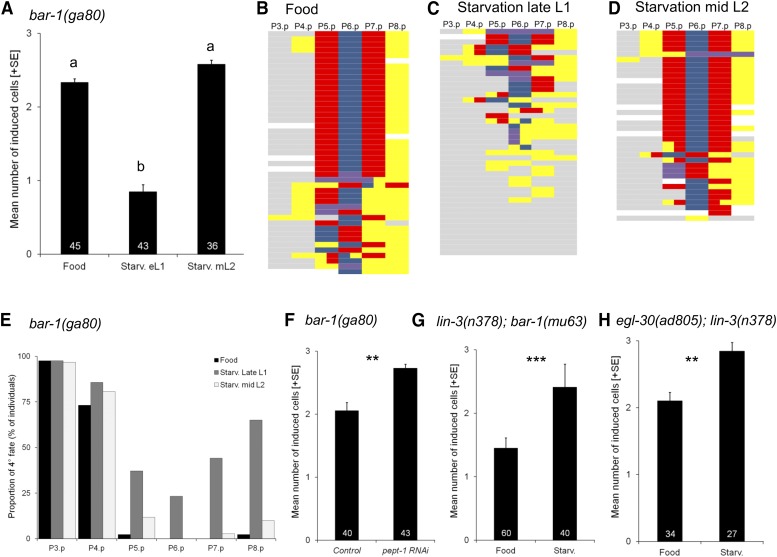
Role of BAR-1 activity in starvation modulation of vulval induction. (A) Differences in vulval induction of bar-1(ga80) animals exposed to 48 hr of starvation in late L1 vs. mid L2 (and vs. control food conditions). Starvation at the late L1 stage, but not at the mid L2 stage, significantly reduced vulval induction of bar-1(ga80) animals (ANOVA, F2,121 = 50.27, P < 0.0001). (B-D) Individual bar-1(ga80) fate patterns of P3.p to P8.p in (B) food vs. starvation conditions: late L1 (C) or mid L2 starvation (D). Vulval cell fate patterns of P3.p to P8.p (B-D) were, whenever feasible, separately inferred for Pn.pa and Pn.pp in cases of half-induced fates. Each line represents the vulval pattern of a single individual, and individuals are ordered from highest to lowest index of vulval induction. Color coding of vulval cell fates (1°: blue, 2°: red) and non-vulval cell fates (3°: yellow, 4°: gray). Induced vulval cells that could not be clearly assigned to either a 1° or 2° fate are coded in purple; non-induced cells that could not be clearly assigned a 3° or° fate are coded in white. (E) Proportion of Pn.p cells with a 4° (Fused) fate in control, starvation-exposed late L1, starvation-exposed mid L2 bar-1(ga80) individuals (from the same experiment as shown in (A)). The proportions of 4° fates for each of P5.p to P7.p cell were higher after L1 starvation (P5.p: 37%, P6.p: 23%, P7.p: 44%) compared to control (P5.p: 2%, P6.p and P7.p: 0%) and L2 starvation (P5.p: 12%, P6.p: 0%, P7.p: 3%). (F) pept-1 RNAi increases vulval induction of bar-1(ga80) animals (ANOVA, F1,81 = 14.47, P = 0.0003). (G) Starvation increased vulval induction of lin-3(n378); bar-1(mu63) relative to control food conditions (ANOVA, F1,98 = 18.84, P < 0.0001). (H) Starvation increased vulval induction of egl-30(ad805); lin-3(n378) relative to control food conditions (ANOVA, F1,59 = 7.28, P = 0.0091).